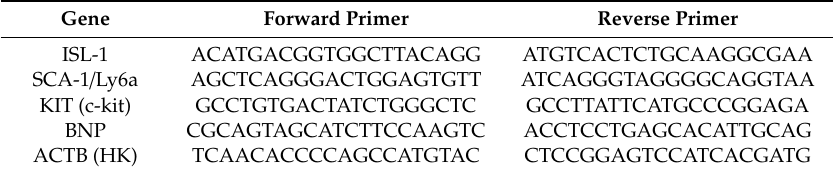
Table 1. Primer list of genes used for pCPC characterization. Housekeeping genes are abbreviated with